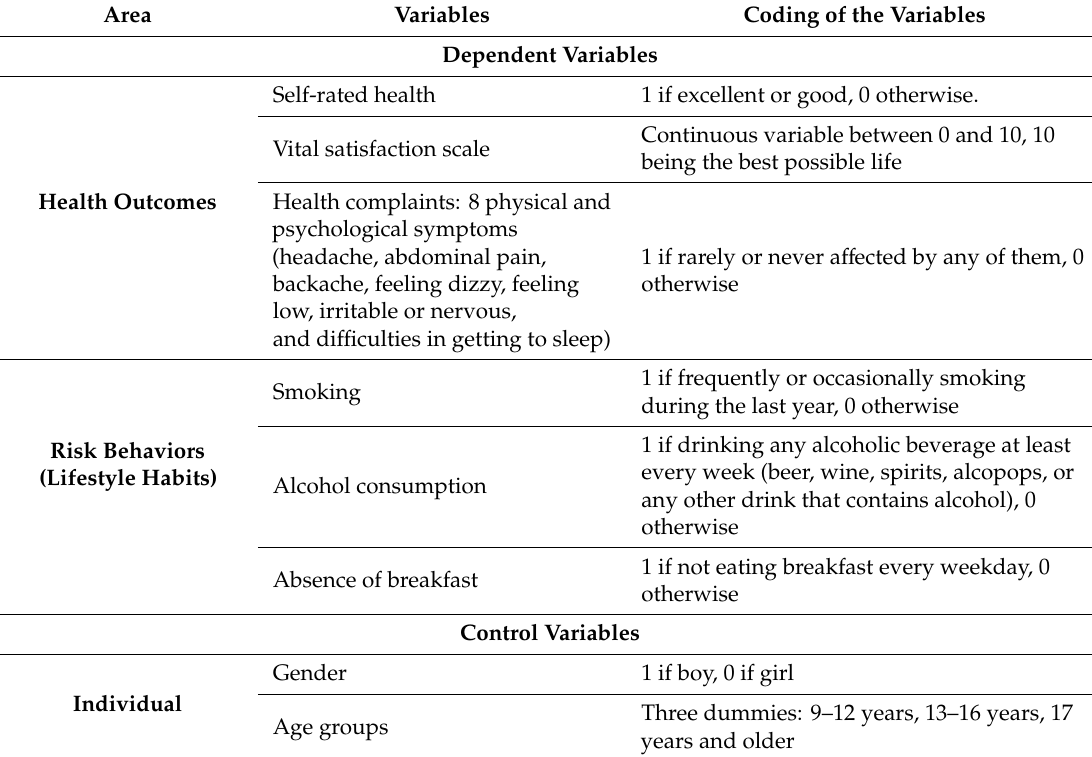
Table 1. Variables included in the